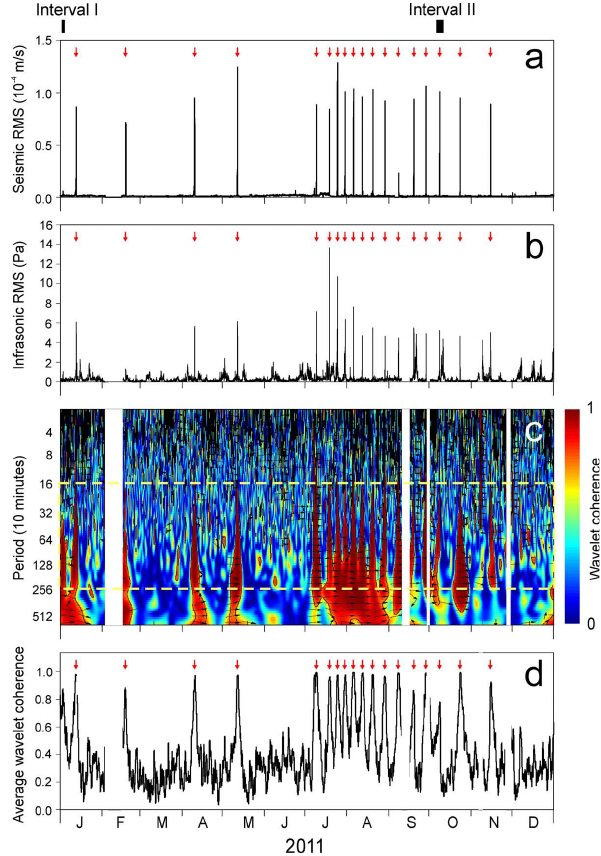
Fig. 2. (a) RMS velocity of the vertical component of the seismic signal at EBEL station calculated on 10-min-long windows filtered in the band 0.5–5.5Hz. (b) RMS pressure of the infrasonic signal recorded by EBEL station calculated on 10-min-long windows fil- tered in the band 0.5–5.5Hz. (c) Wavelet coherence between the time series in (a) and (b ). The 5% significance level against red noise is shown as a black contour. The black arrows indicate the phase difference between infrasonic and seismic RMS (a horizon- tal arrow pointing from left to right signifies in phase and an arrow pointing vertically upward means the first series lags the second one by 90 ◦ ). (d) Variation in time of coherence calculated by averaging the values falling in the yellow dashed rectangle in (c) . The black rectangles and the label “Interval I” and “Interval II”, at the top of (a) , indicate the time spans analysed in Figs. 3–6. The red vertical arrows in (a) , (b) , and (d) indicate the lava fountain occurrences. WTC was computed by Matlab toolbox provided by Grinsted et al. (2004). The white rectangle in (c ) in February indicates a time span with no